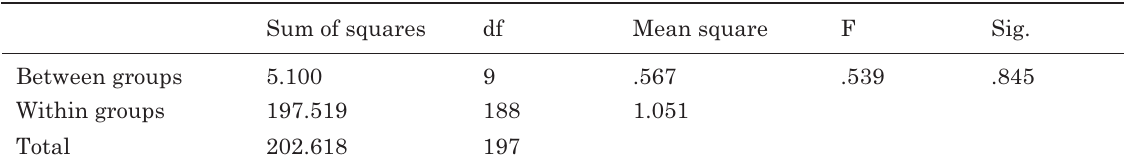
Table 7. Model Summary Table 8. ANOVA for studentized residual